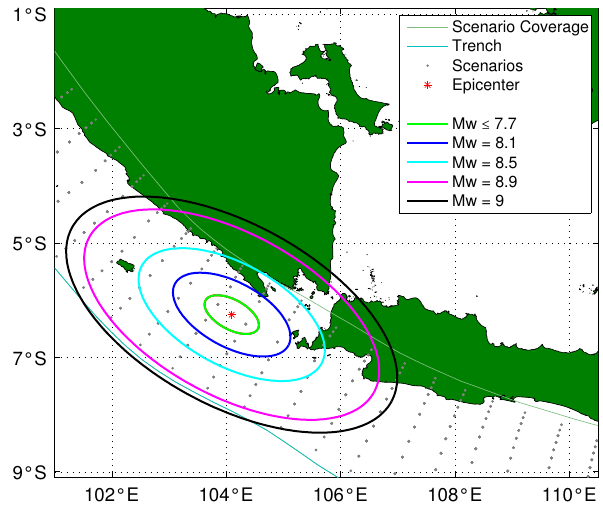
Fig. 15. Seismic uncertainty ellipses for different